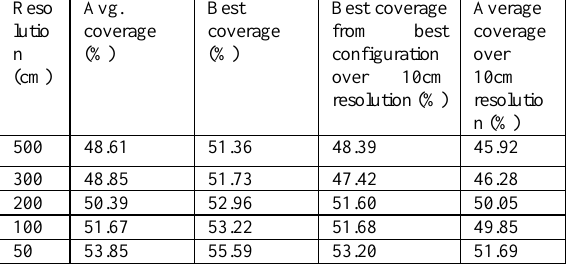
Table 5: Results obtained from the context-aware method, considering the urban surface